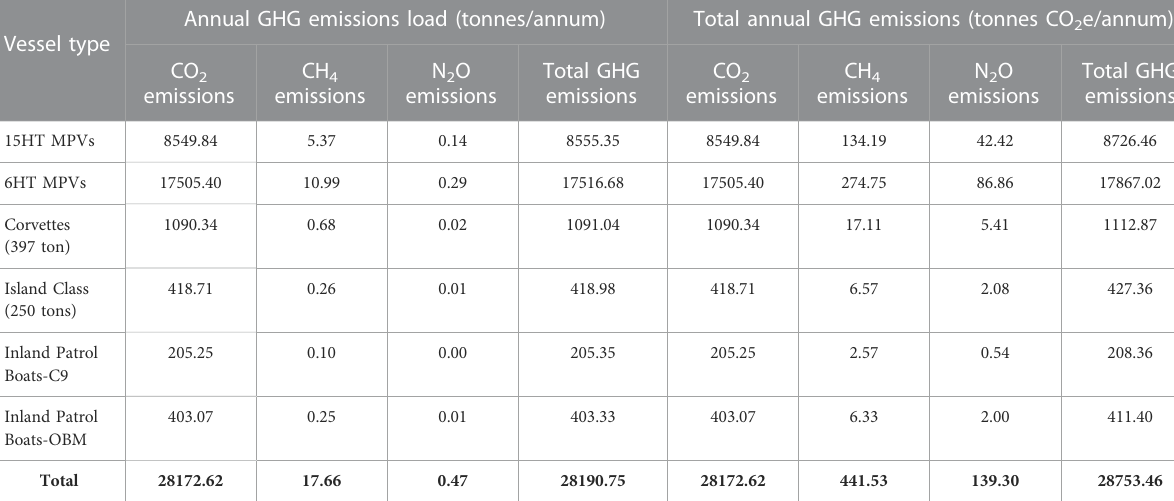
TABLE 11 Breakdown of total GHG Emissions from PMSA Fleet.